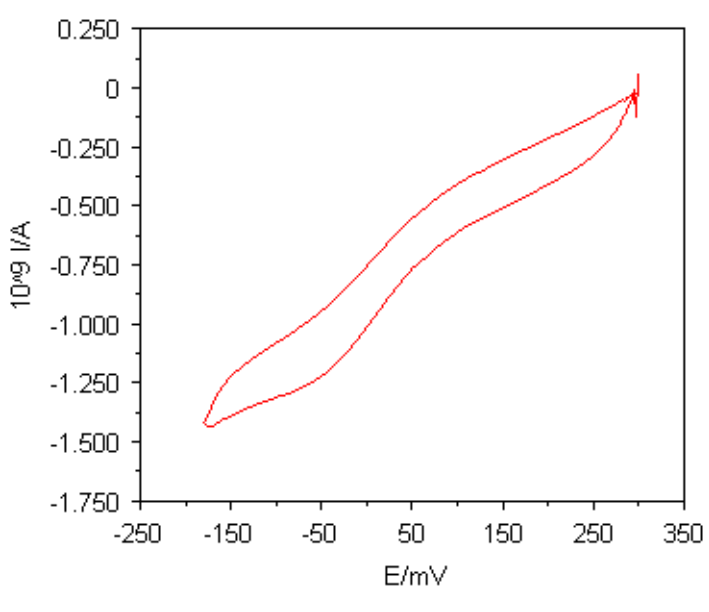
Figure 5. A cyclic voltammogram of 45 µ M horse heart cytochrome c in 5mM sodium phosphate buffer (pH 7.0) and 100mM NaCl at a 5 µ m carbon Multi MEA; potential scan rate, 20mVs -1